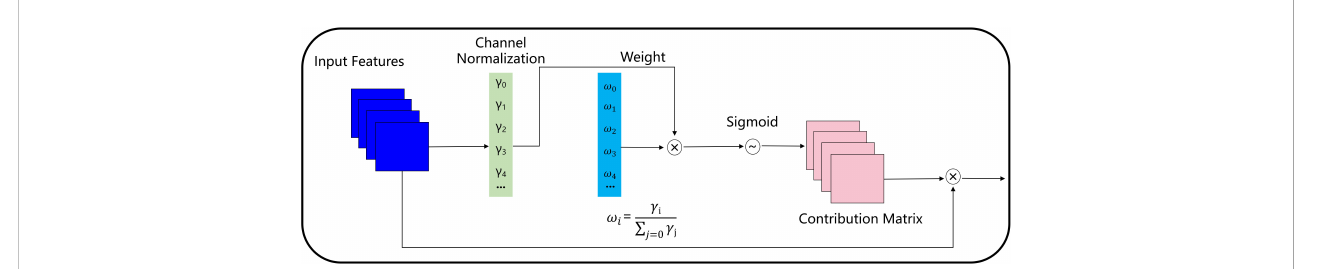
FIGURE 7 Fusion mechanism of weight contribution factors based on batch normalization. Where, g i represents the weight value of the i-th channel calculated in batch normalization, g j represents the weight value of the j-th channel calculated in batch normalization, w i represents the importance degree of the i-th